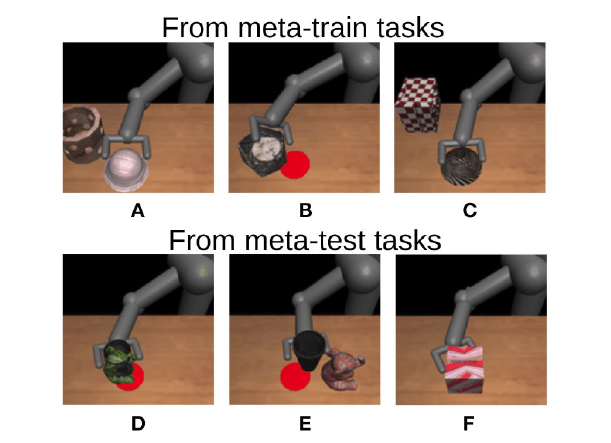
FIGURE 3 | Demonstrations with highest variances in task embedding space of PETNet. Demonstrations in the first row are from meta-training tasks, while those in the second row are from meta-test tasks. These demonstrations can be inappropriate for task identification for the controller, for example, in (A–E) , the arm pushes both target object and distractor, especially in (B) and (D) , they are overlapping, and in (F) , the target object is completely occluded by the other.